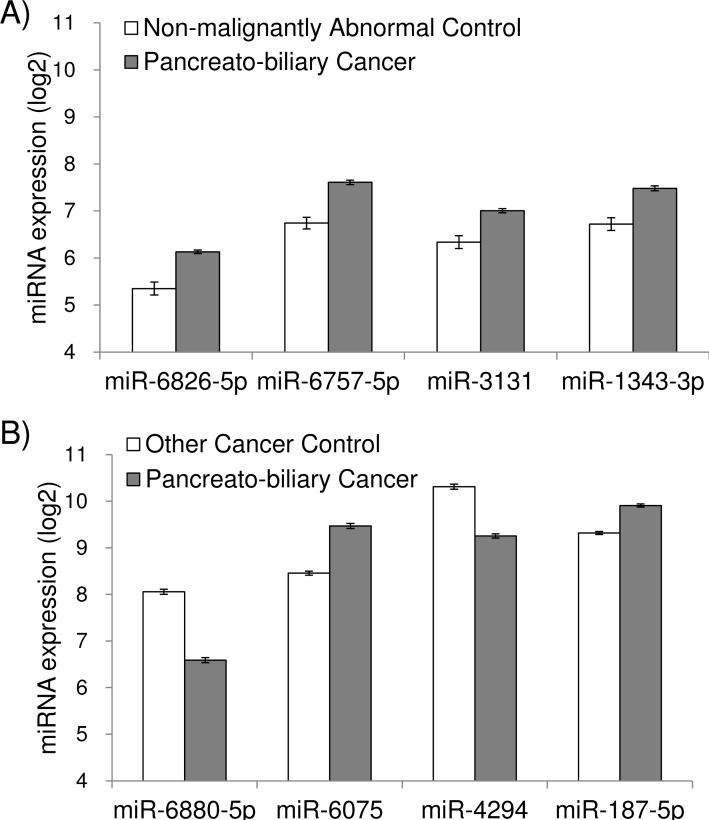
Expression signals of validated miRNAs that differentiated pancreato-biliary cancer from non-malignant abnormalities (A), or from cancers of other types (B).The error bars indicate standard error. The p-values were Bonferroni-corrected.